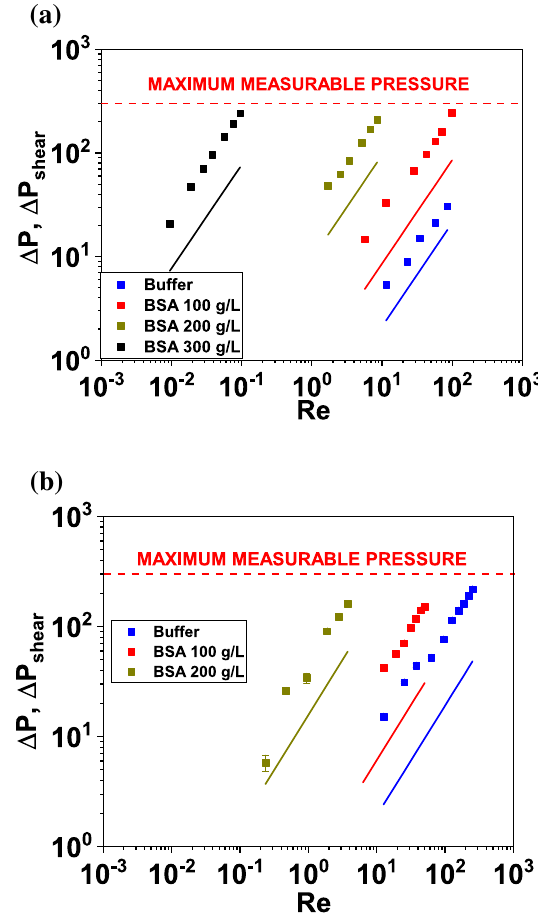
Fig. 7 The steady pressure drops through the “26-G ” ( a ) and “27-G ” ( b ) channels plotted as a function of Re for buffer and the BSA solu- tions. Symbols refer to experimental data points, and lines corre- spond to the analytical prediction as in Eqs. (7) and